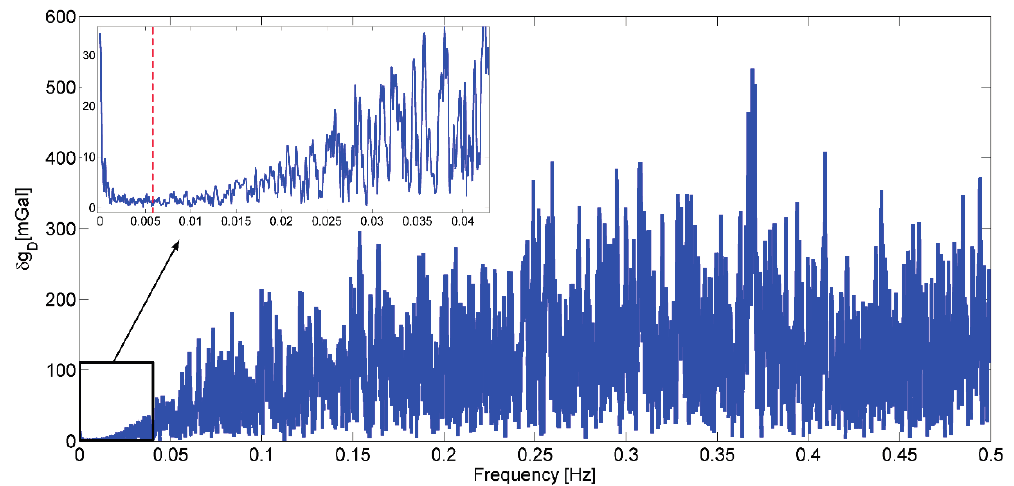
Figure 5. Spectrum of raw gravity measurements. The red dot line shows the cut-off frequency is 0.00625 Hz (correspond to a 160 s length filter).